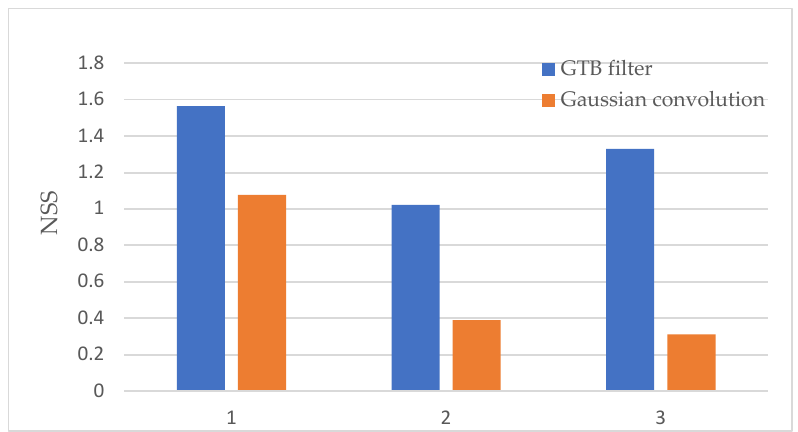
Figure 6. NSS value results for GTB method and Gaussian method.